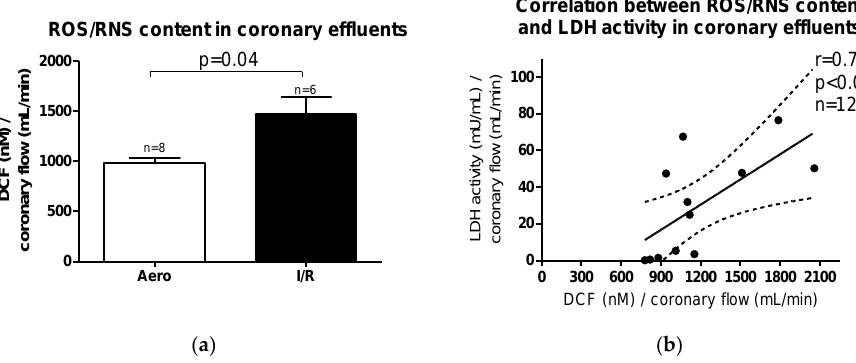
Figure 3. ( a ) Reactive oxygen/nitrogen species (ROS/RNS) content in coronary effluents; ( b ) Correlation between ROS / RNS content and lactate dehydrogenase (LDH) activity in coronary e ffl uents. DCF-2 (cid:48) ,7 (cid:48) –dichlorodihydrofluorescein; all data are expressed as mean ±